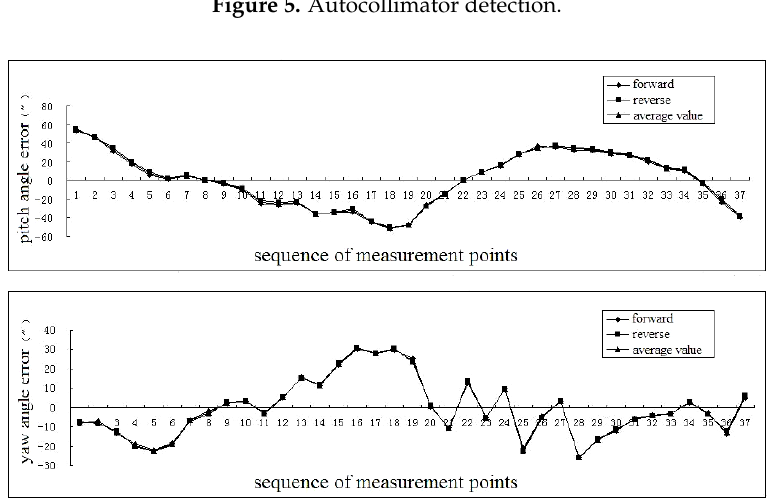
Figure 6. Pitch and yaw angle error of slider 1. Table 2. Error contributed by Abbe error of three